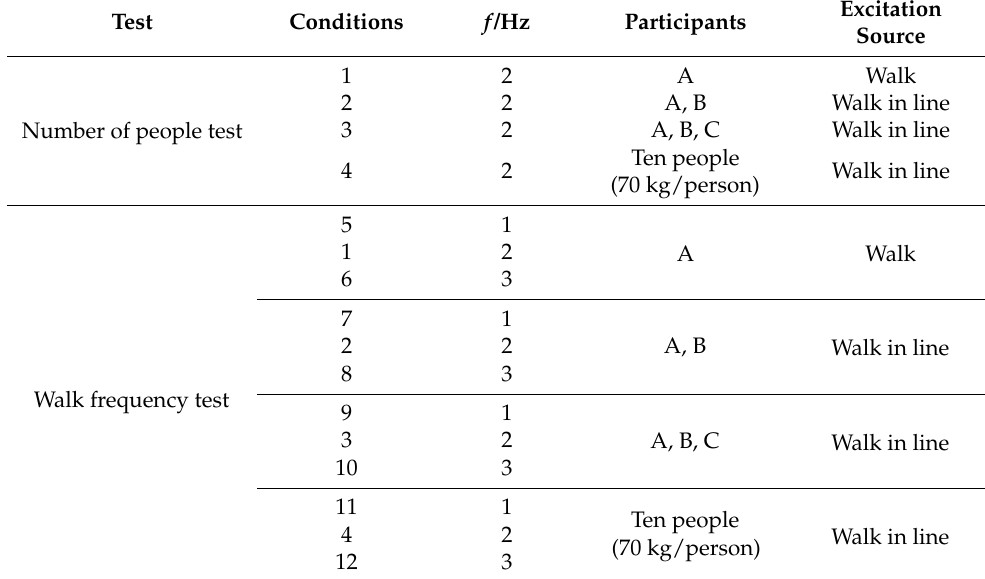
Table 2. Conditions information.